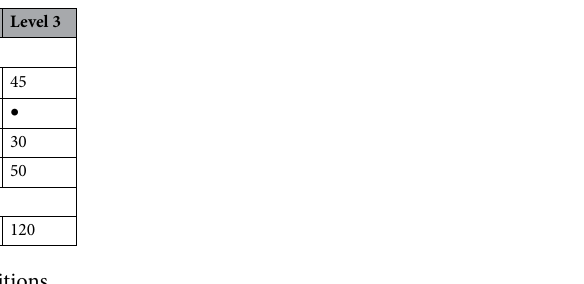
Table 1. Design parameters and user